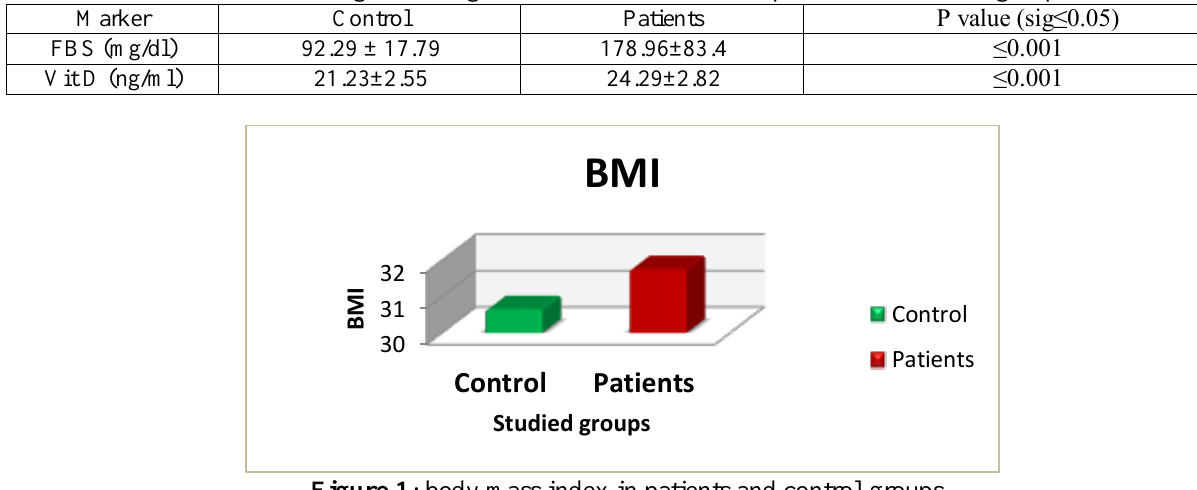
Figure 1 : body mass index in patients and control groups.